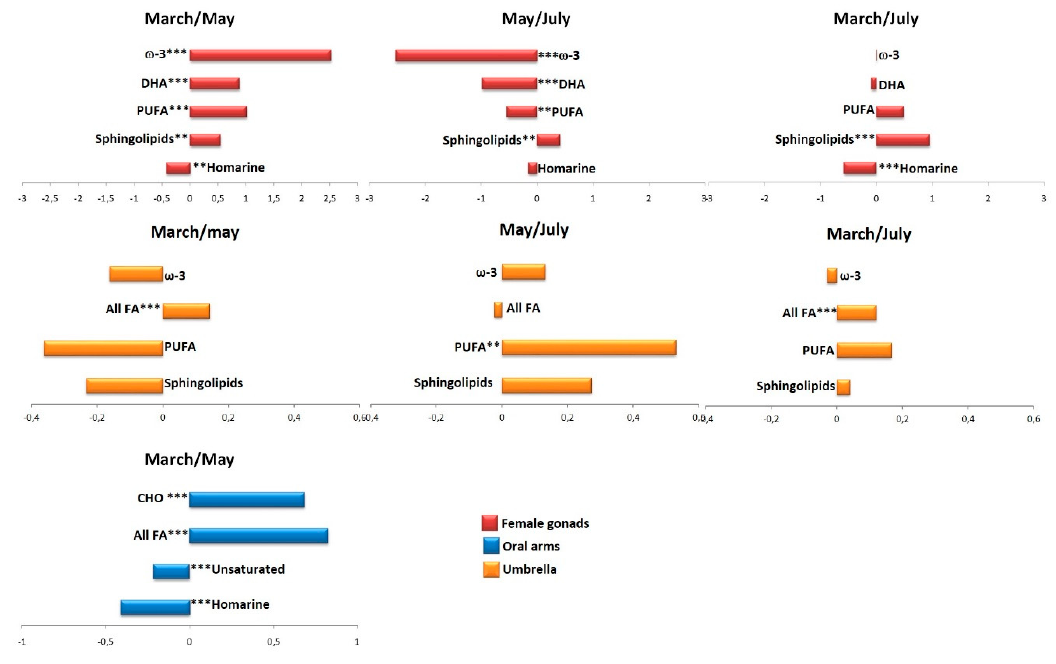
Figure 6. Variation in discriminating metabolites content for each compartments, among the di ff erent sampling (March, May, and July). Signif. codes: ‘***’ 0.001 ‘**’ 0.01 ‘*’ 0.05 ‘.’ 0.1 ‘ns’ 1.